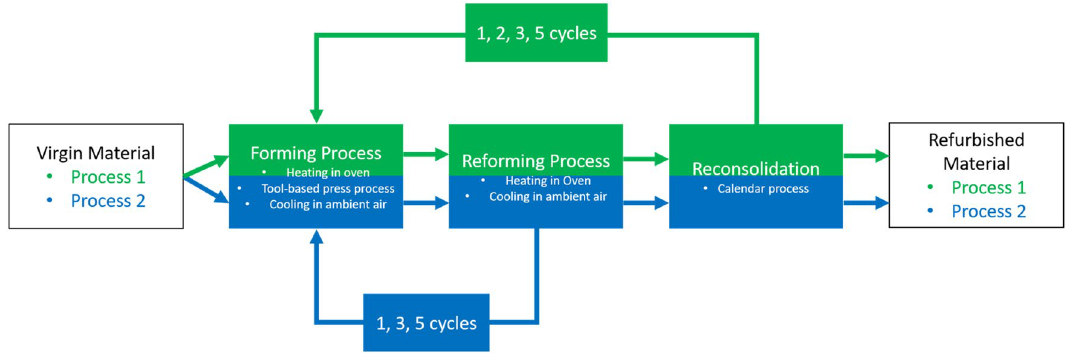
Fig. 4 Illustration of the different process chains for the reforming process